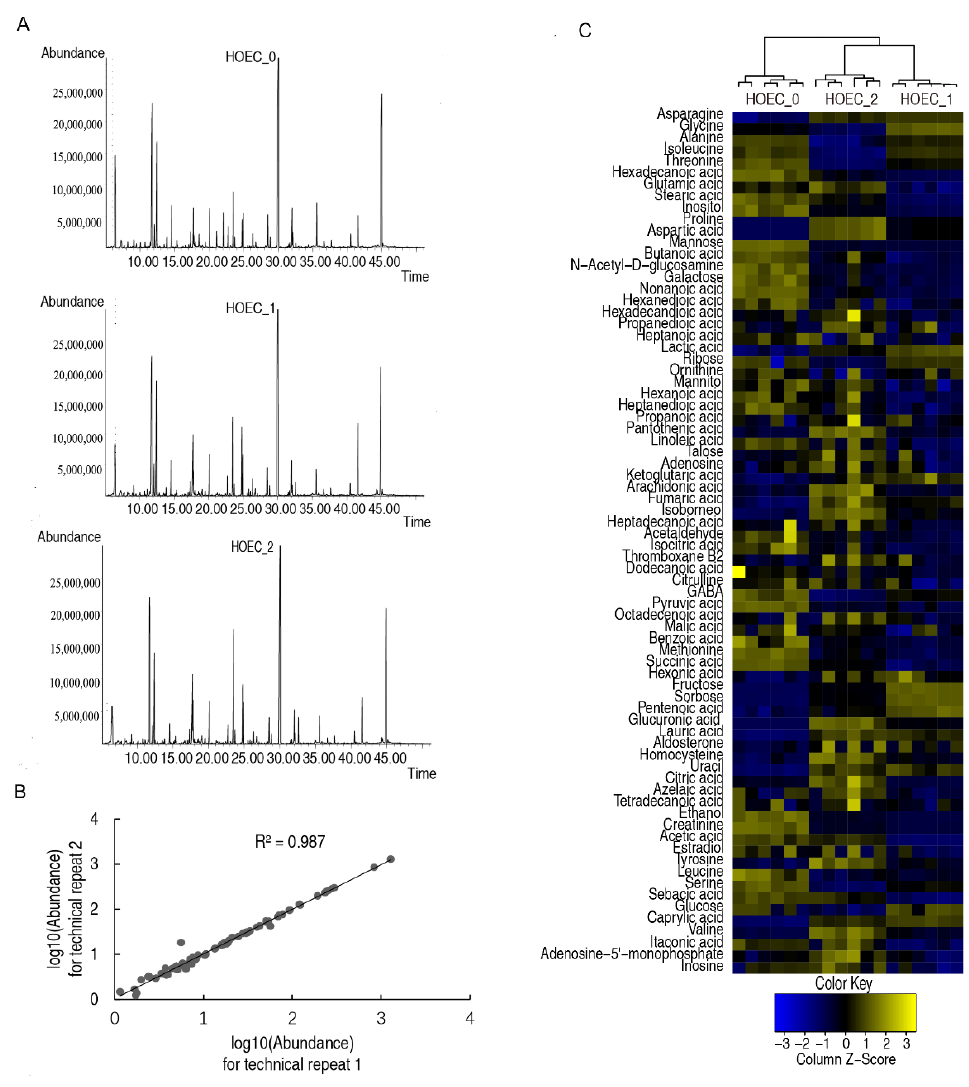
Figure 5. Metabolomics profiles of HOEC cells. Representative total ion current chromatograms ( A ). Reproducibility of the metabolomics profiling platform ( B ). Cluster analysis of all metabolites ( C ). HOEC_0, HOEC_1 and HOEC_2 represent the HOEC cells treated with cisplatin for 0 h, 24 h or 48 h.